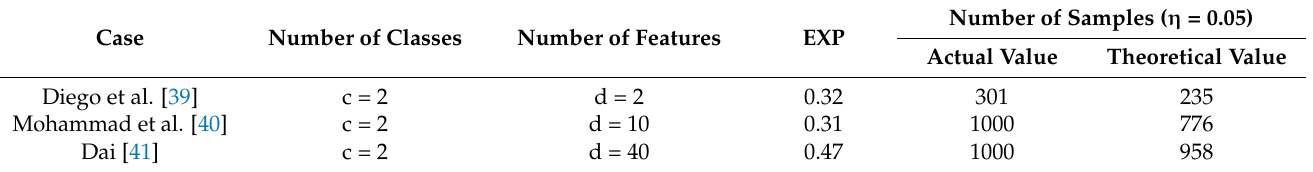
Table 3. The comparison results between the actual and the computed theoretical values on the lower bound of the sample size estimated in Equation